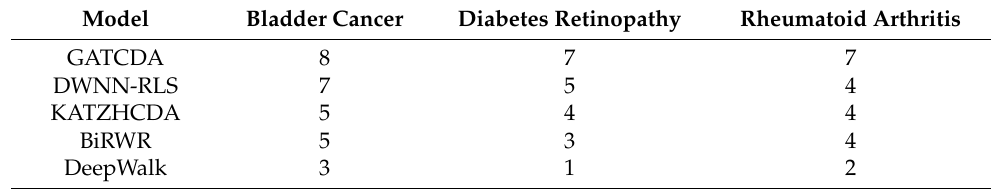
Table 2. The number of circRNAs confirmed by evidence in the top 10 potential disease-related circRNAs predicted by GATCDA and other models in case studies of the three kinds of diseases such as bladder cancer, diabetes retinopathy, and rheumatoid